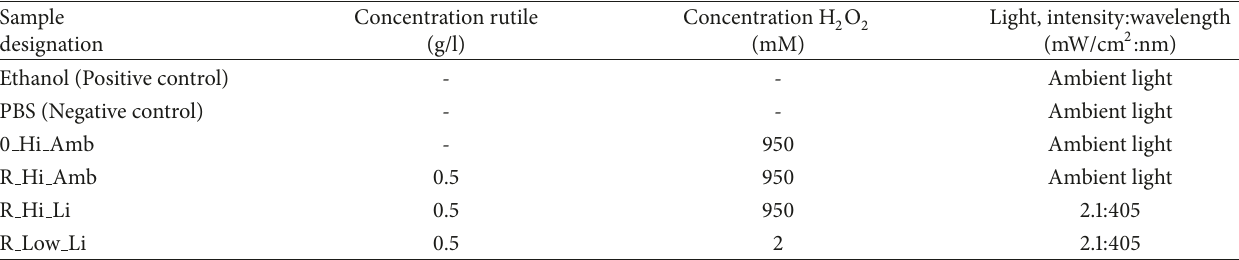
Table 1: Description of debridement treatment conditions. Exposure time was 1 min for all treatment conditions.